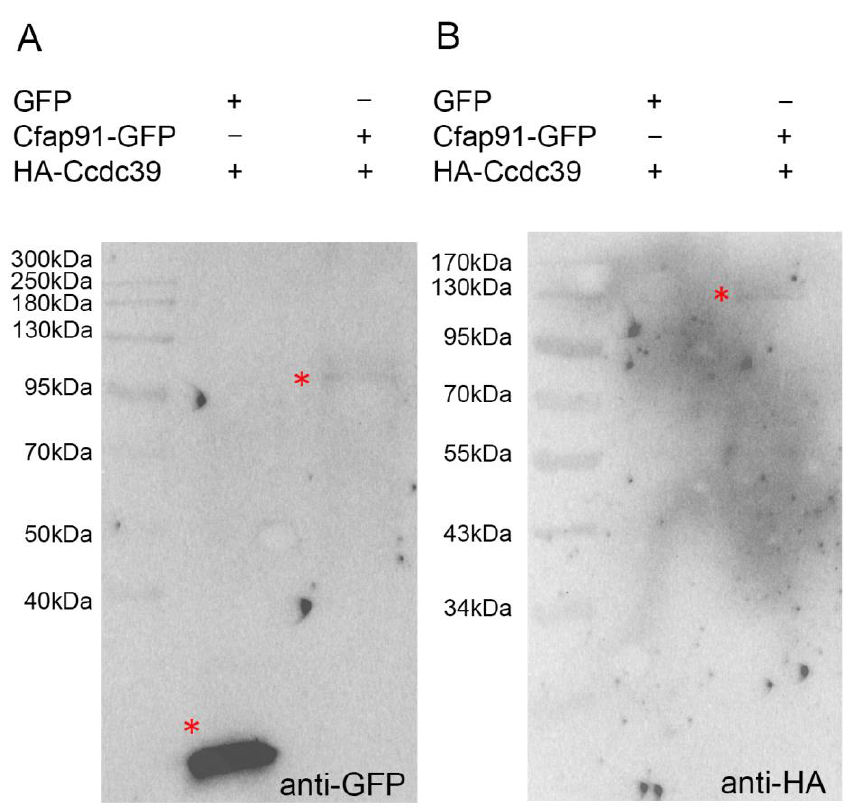
Figure 9. Cfap91-GFP interacts with HA-tagged molecular ruler protein, Ccdc39. GFP and Cfap91- GFP proteins were purified from the cytoplasm of GFP or Cfap91-GFP overexpressing cells using magnetic agarose beads-conjugated anti-GFP antibodies and after washings, incubated with a cyto- plasmic extract obtained from cells overexpressing HA-Ccdc39 proteins (118 kDa). ( A ) A Western blot showing that either GFP (26 kDa, first line) or Cfap91-GFP (102 kDa, second line) proteins (both indicated by a red star) were bound to the magnetic beads. ( B ) A corresponding Western blot showing that HA-Ccdc39 was pulled-down by the GFP-Cfap91 protein but not by GFP alone. Chlamydomonas FAP61, FAP91, and FAP251 were co-immunoprecipitated from pf14